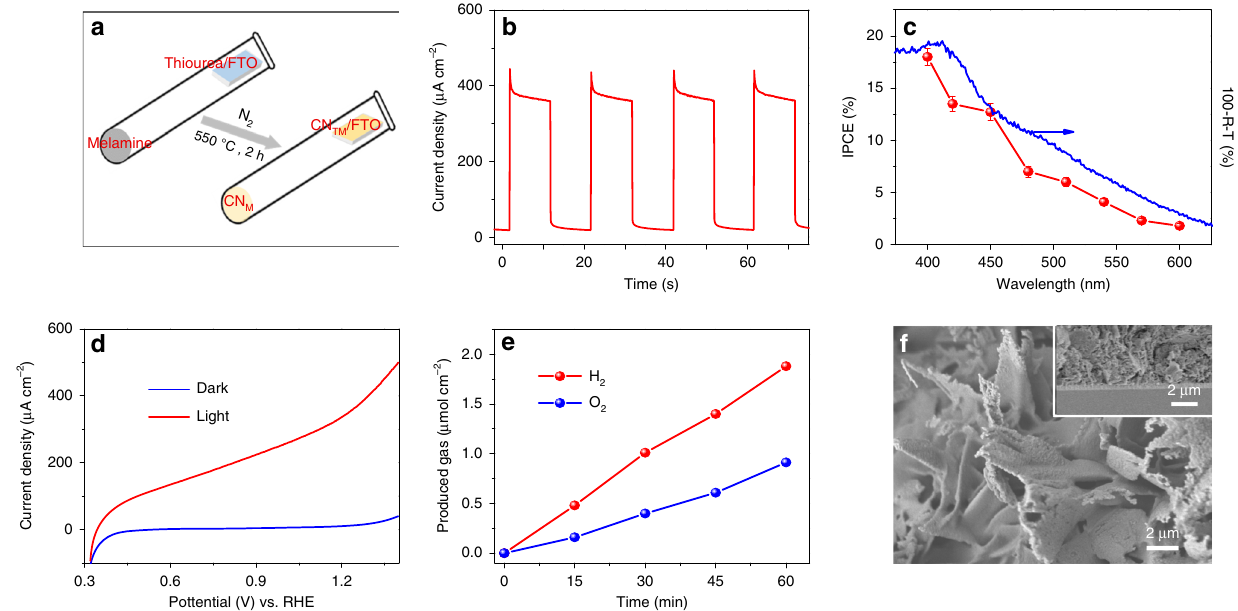
Fig. 5 Characterization of CN TM photoanodes. a Schematic synthetic process of CN TM fi lm on FTO. b Photocurrent density (chronoamperometry) upon 1- sun cycling illumination of CN TM electrode at 1.23 V vs. RHE in 0.1 M KOH. c IPCE plots of CN TM as a function of incident wavelength in 0.1 M KOH and the corresponding UV – Vis spectrum of the CN TM electrode. d LSV curves of CN TM electrode in 0.1 M KOH. e Time-production plot of the H 2 and O 2 generated from the PEC system with CN TM at 1.23 V vs. RHE in 0.1 M KOH upon 1-sun illumination. f Top-view (inset: cross-sectional) SEM images of CN TM fi lm on FTO. (The light yellow powder labeled as CN M in frame a refers to carbon nitride obtained by calcination of melamine powder at 550 °C for 2 h at the bottom of the tube). Each IPCE (%) data point represents an average of three different CN TM electrodes; error bars represent standard